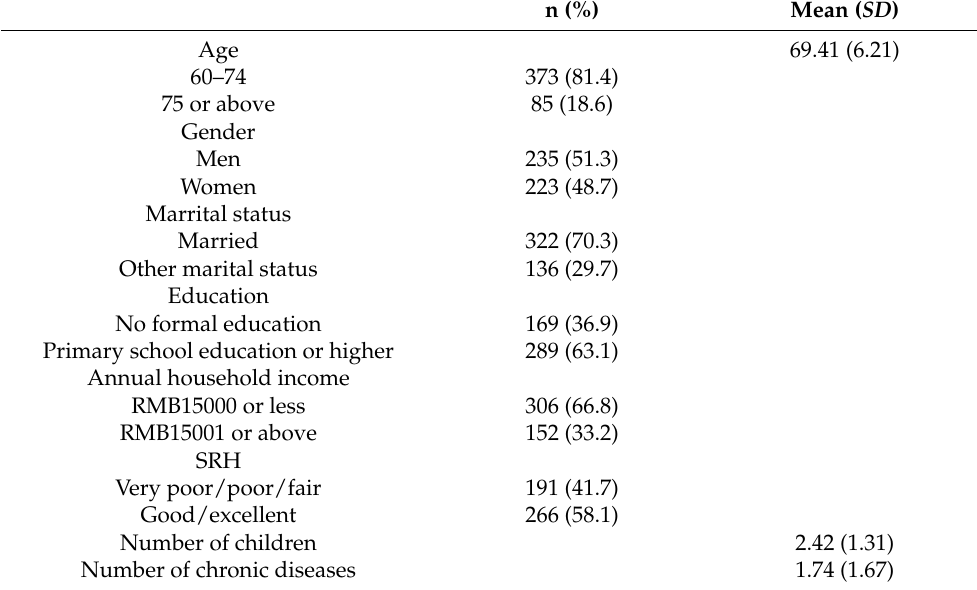
Table 1. Sample characteristics (N = 458)